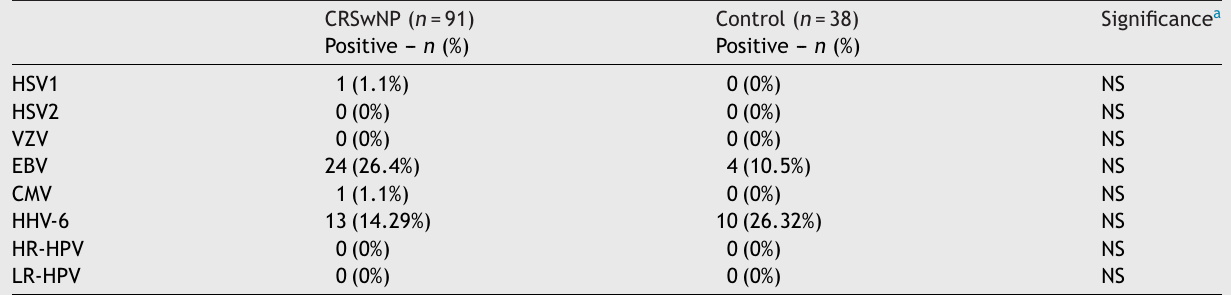
Rates of HSV-1, HSV-2, VZV, CMV, EBV, HHV-6, and HPV (HR-HPV and LR-HPV types) in chronic rhinosinusitis with nasal polyps (CRSwNP) and control